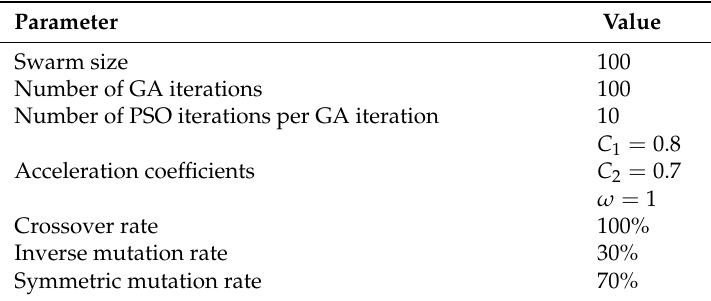
Table 3. Experimental parameters for HPSO-MMEP